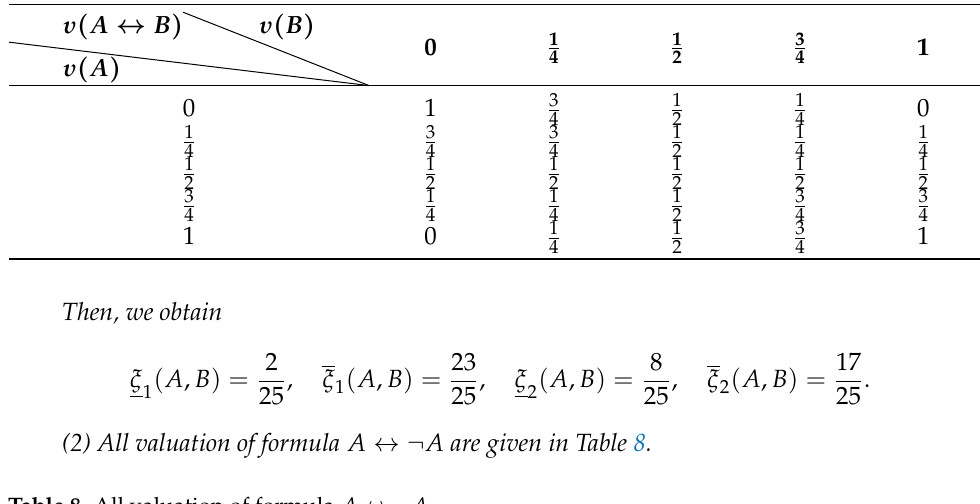
Table 7. All valuations of formula A ↔ B .